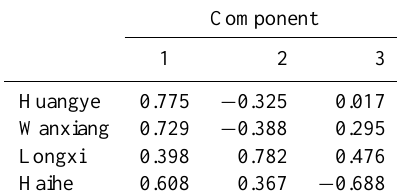
Table 1. Component matrix a .